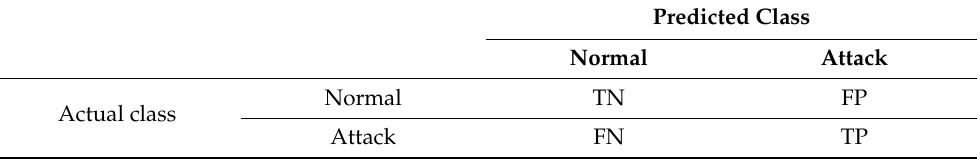
Table 1. Metrics used to assess the performance of